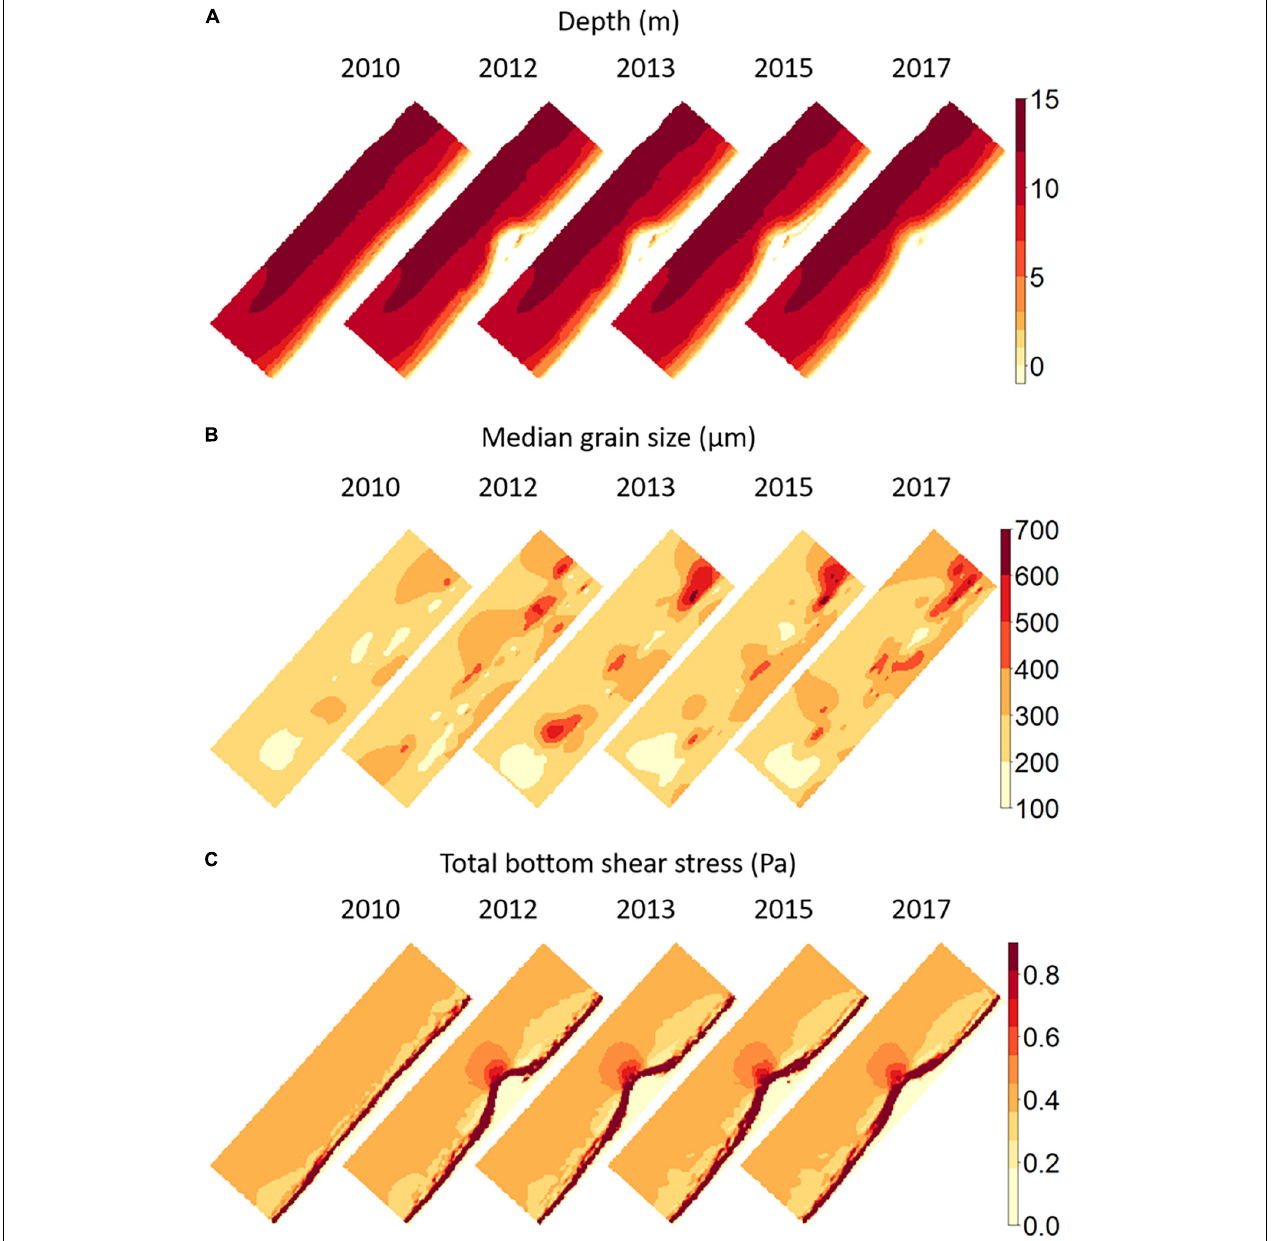
FIGURE 7 | Maps of (A) depth, (B) median grain size, and (C) log-transformed bottom shear stress in the Sand Motor area before (2010) and after construction. Bathymetry was based on extensive bathymetric surveys (de Schipper et al., 2016); the map shown here is the bathymetry used in the model, which was also the origin of the estimated total bottom shear stress shown in (C) . The median grain size map (B) is a kriging interpolation of observed values in the benthic sampling locations.